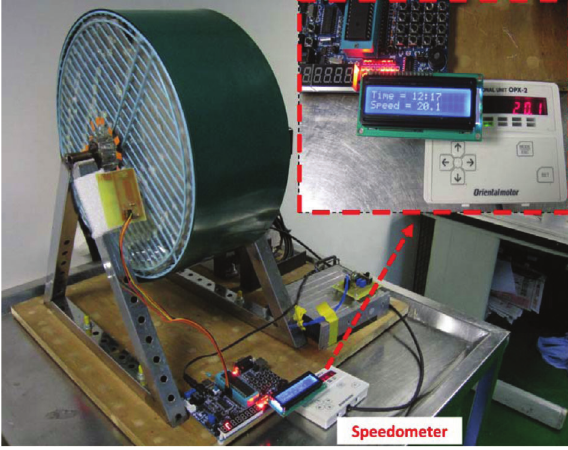
Figure 6. Speedometer used for speed